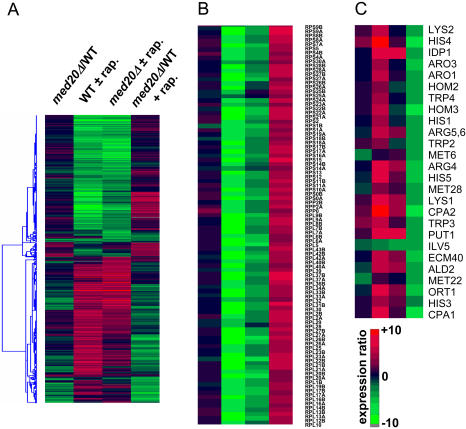
Microarray expression profiles of wild-type and med20Δ strains before and after treatment with rapamycin.Clustergram comparisons of gene expression profiles obtained in dye-swap experiments under four conditions; from left to right in each panel, med20Δ/MED20, MED20±rapamycin, med20Δ±rapamycin and med20Δ+rapamycin/MED20+rapamycin. RNA samples were prepared from cells grown at 30°C. Decreased (green) and increased (red) expression is shown relative to the wild-type strain or the untreated control. A The expression of 1420 genes that increased or decrease by two-fold or more in any one of the four pair-wise comparisons were subjected to hierarchical clustering. B The repression of RP genes (96 of 138 genes) by rapamycin was specifically attenuated in the med20Δ strain. The average level of repression of RP genes was only two-fold in the med20Δ strain versus more than six-fold for the wild-type strain. C Rapamycin induction of a subset of Gcn4-regulated genes is diminished significantly in the med20Δ strain. Expression ratios are compared for 25 Gcn4-regulated genes involved in amino acid biosynthesis.